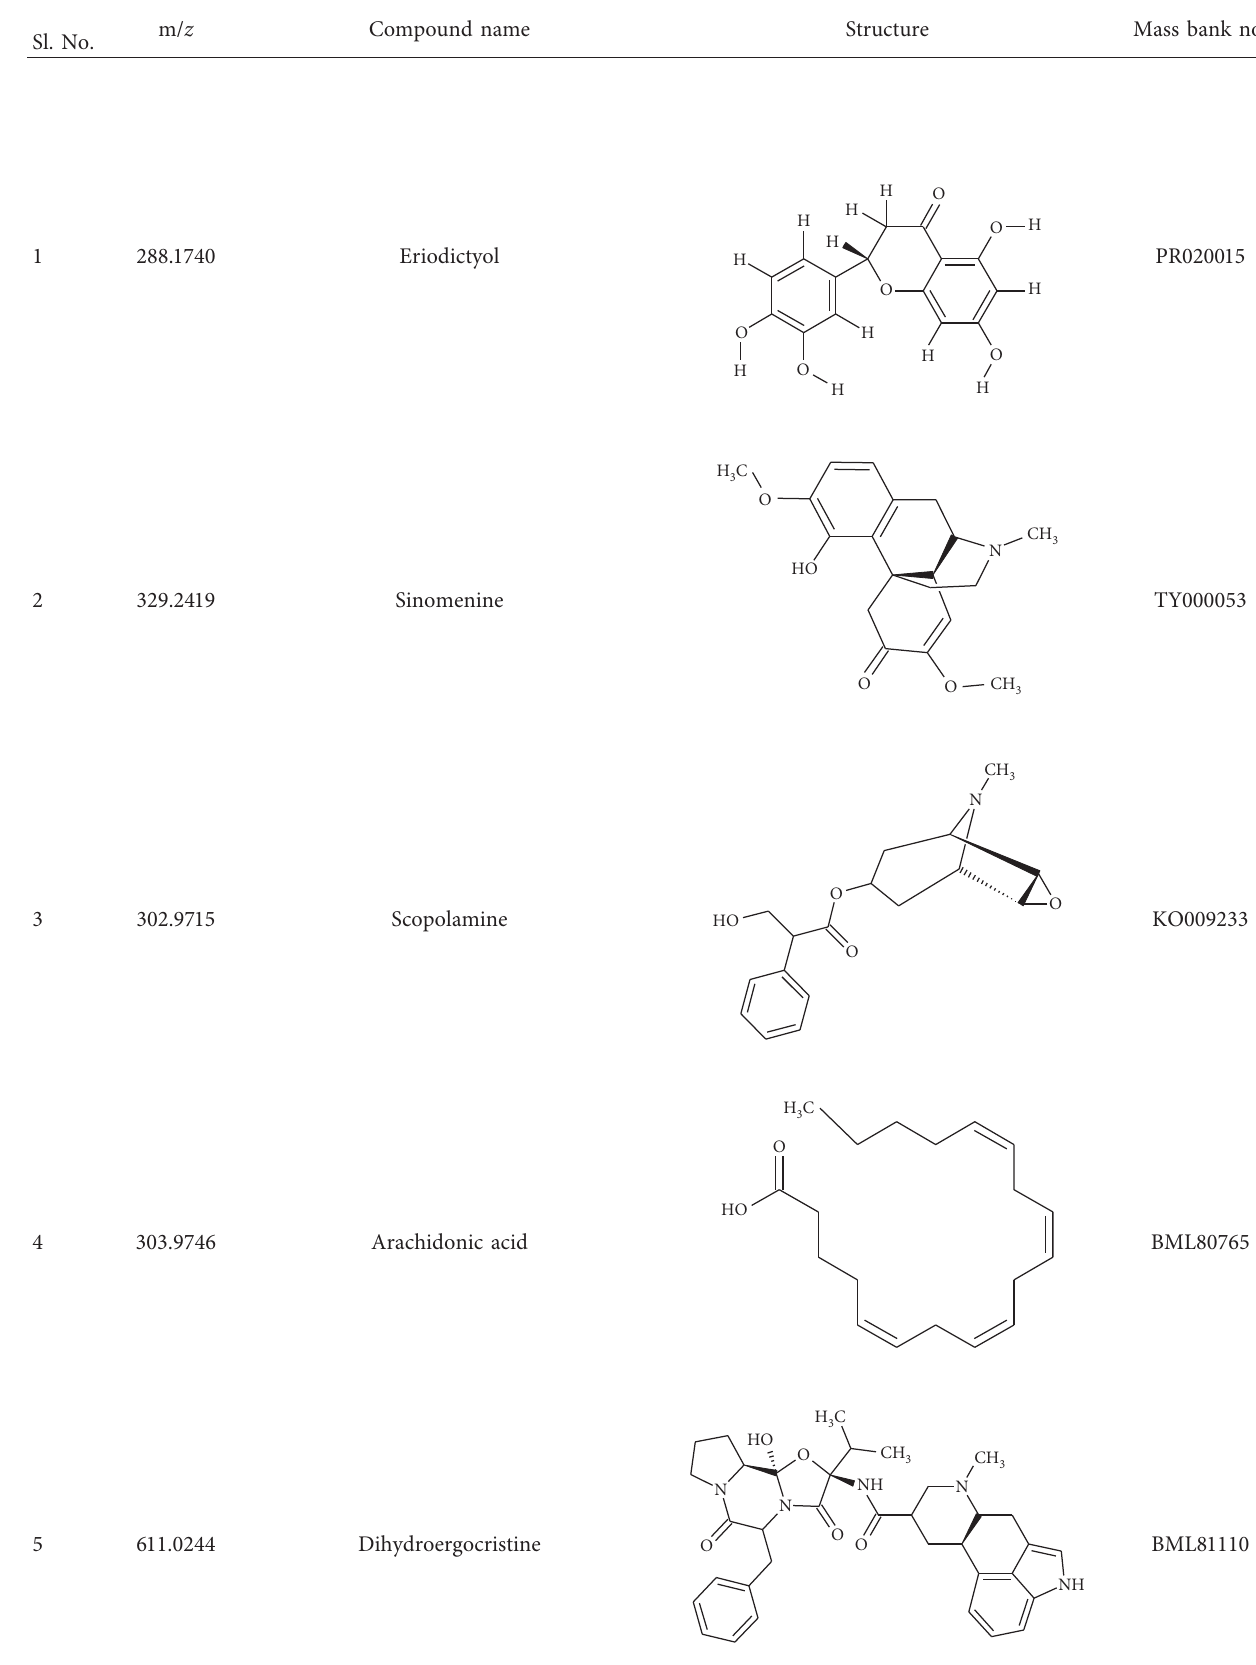
Table 6: Predicted identified compounds using